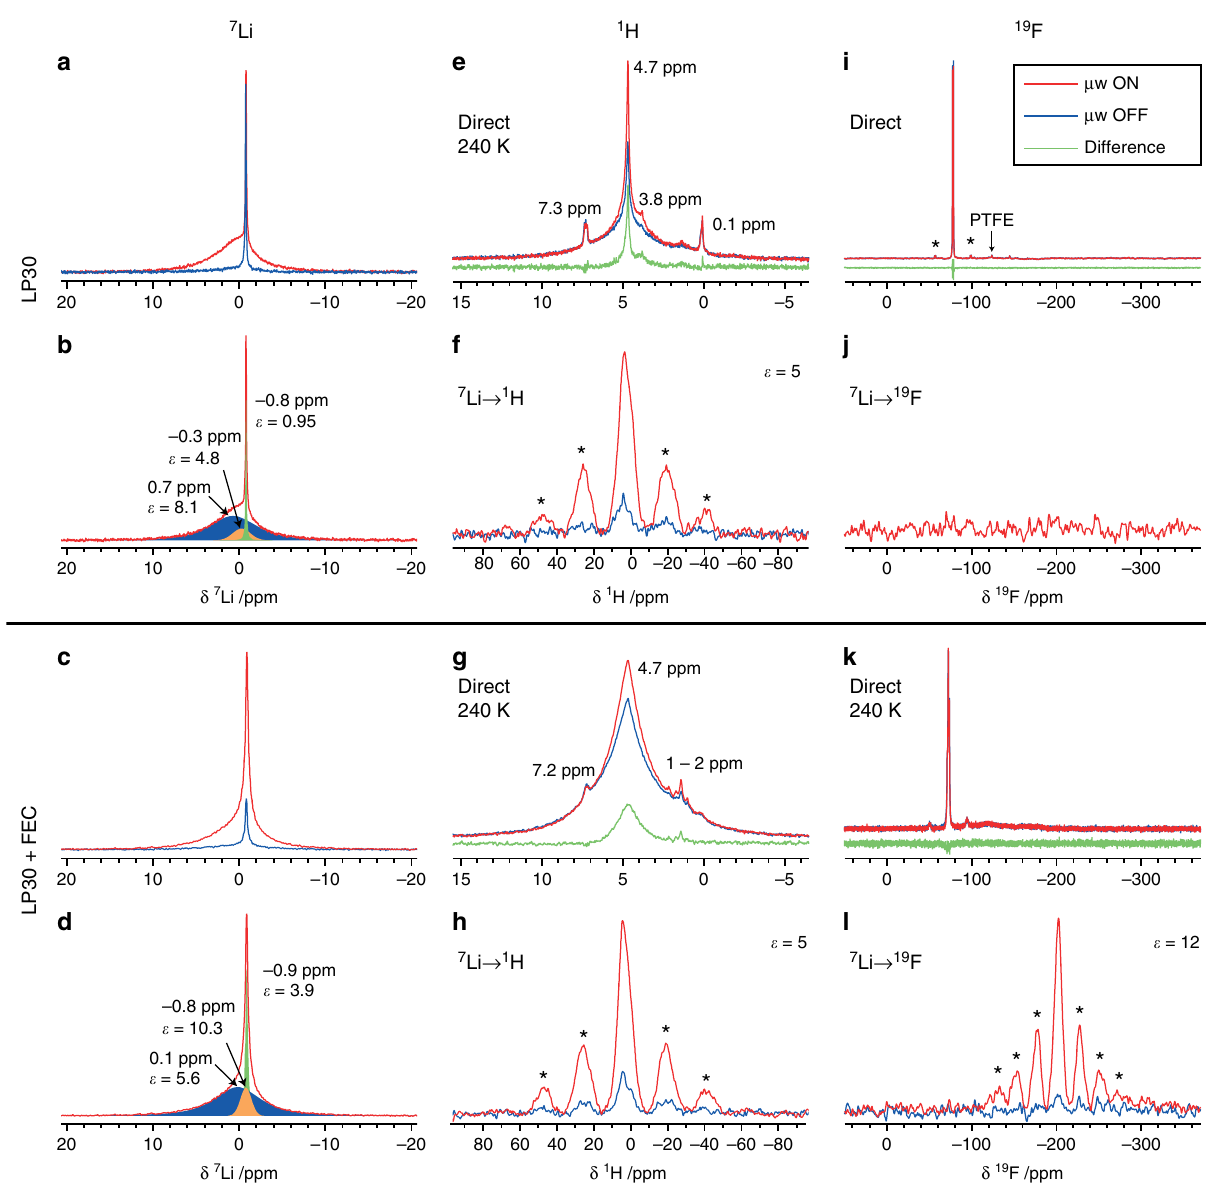
Fig. 3 Selective enhancement of the SEI by Li metal DNP. Diamagnetic 7 Li ( a – d ), 1 H ( e – h ), and 19 F ( i – l ) NMR spectra of lithium microstructures produced by cycling with the LP30 (top half, sample D) and LP30 + FEC (bottom half, sample E) electrolytes, recorded with and without 15.6 W of microwave irradiation ( μ w ON/OFF). ( b ) and ( d ) are deconvolutions of the μ w ON spectra in ( a ) and ( c ), respectively; see Supplementary Figs. 15, 16 and Supplementary Table 2. All spectra were recorded at 12.5 kHz MAS, 14.1 T and room temperature, unless otherwise stated. Spinning sidebands are marked with asterisks. The direct spectra were recorded with a Hahn echo pulse sequence and the CP spectra were recorded with the 7 Li carrier at 0 ppm and contact times of 1 and 0.1 ms for 7 Li → 1 H and 7 Li → 19 F respectively. For the direct 1 H and 19 F experiments, the difference between the spectra recorded with and without microwave irradiation is also shown. Recycle delays and experimental times are given in Supplementary Table